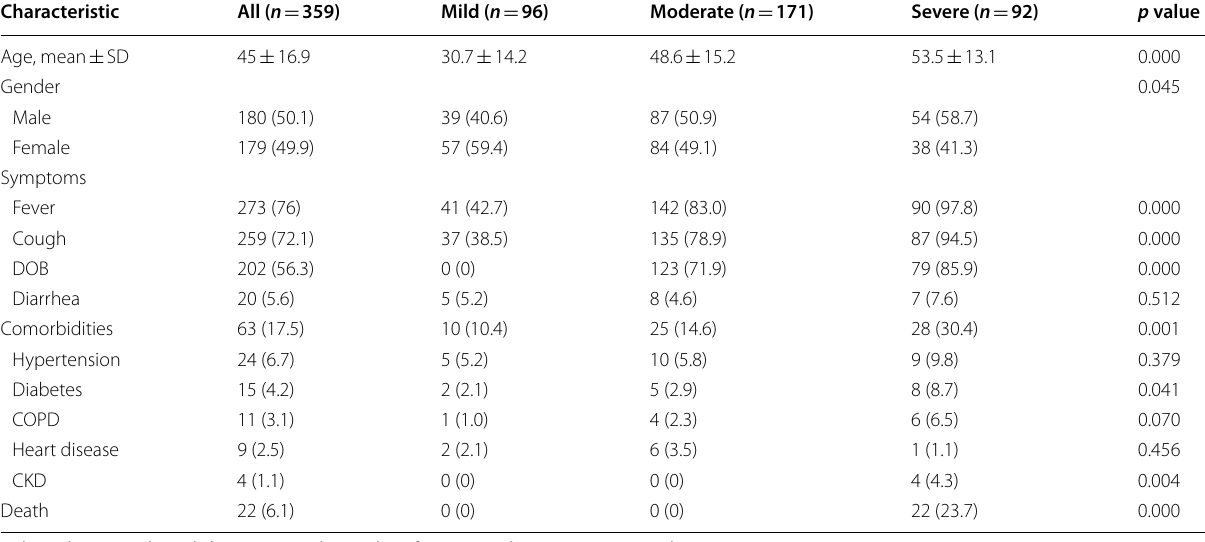
Unless otherwise indicated, date represent the number of patients and percentage in parentheses n number, SD standard deviation, DOB difficulty of breathing, COPD Chronic obstructive pulmonary disease, CKD Chronic kidney disease